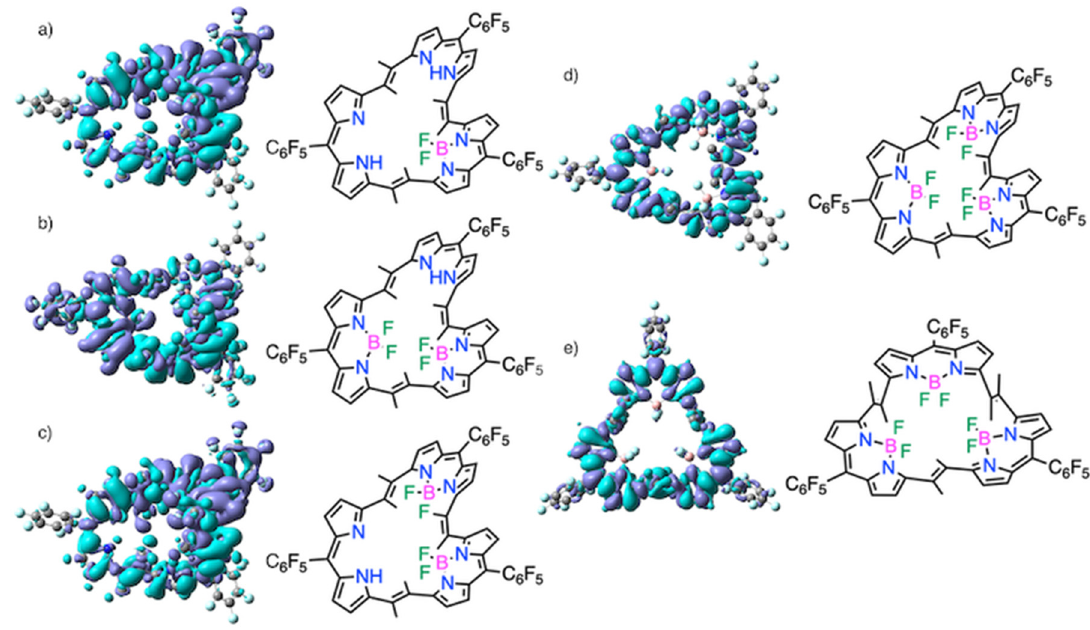
Figure 8. The electron density difference maps (EDDMs) of ( a ) BF 2 -Me-Hex, ( b ) 2BF 2 -Me-Hex(a), ( c ) 2BF 2 -Me-Hex(b), ( d ) 3BF 2 -Me-Hex(a), and ( e ) 3BF 2 -Me-Hex(b).